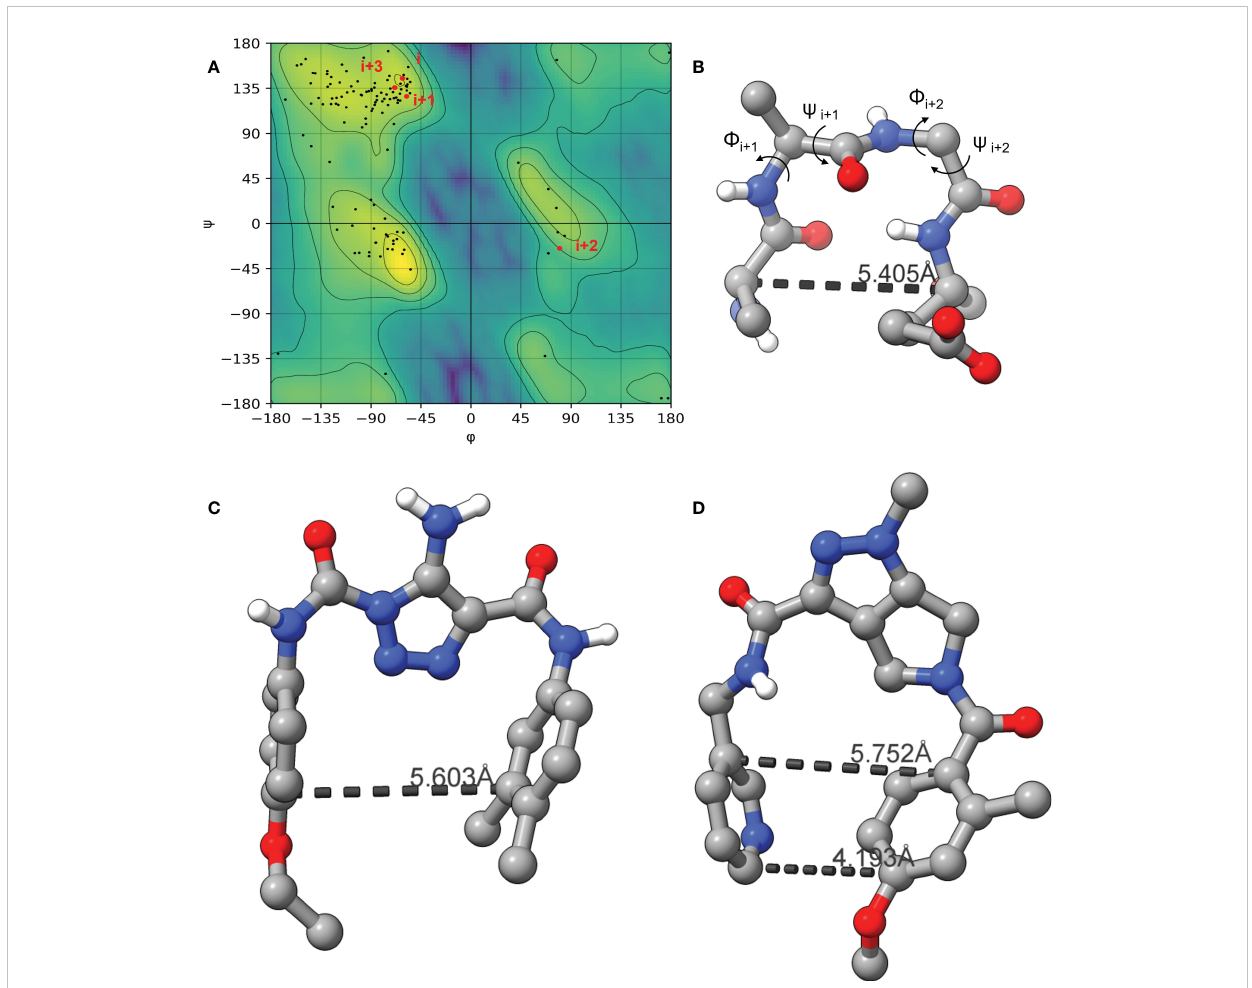
FIGURE 4 The Ramachandran plot of LexA highlighting the dihedral torsions between b -turn residues of the CSR region are presented in (A) . The key atoms in the b -turn of the CSR that contains scissile bond between Ala-84 and Gly-85 are shown in (B) . The dihedral torsions of the CSR b -turn are detailed in Table 1. These torsions determine the classi fi cation of the b -turn. The docked model of the compound GSK-C1 is shown in (C) , (D) is the only b - turn mimetic compound from our screen that took a conformation reminiscent of the b